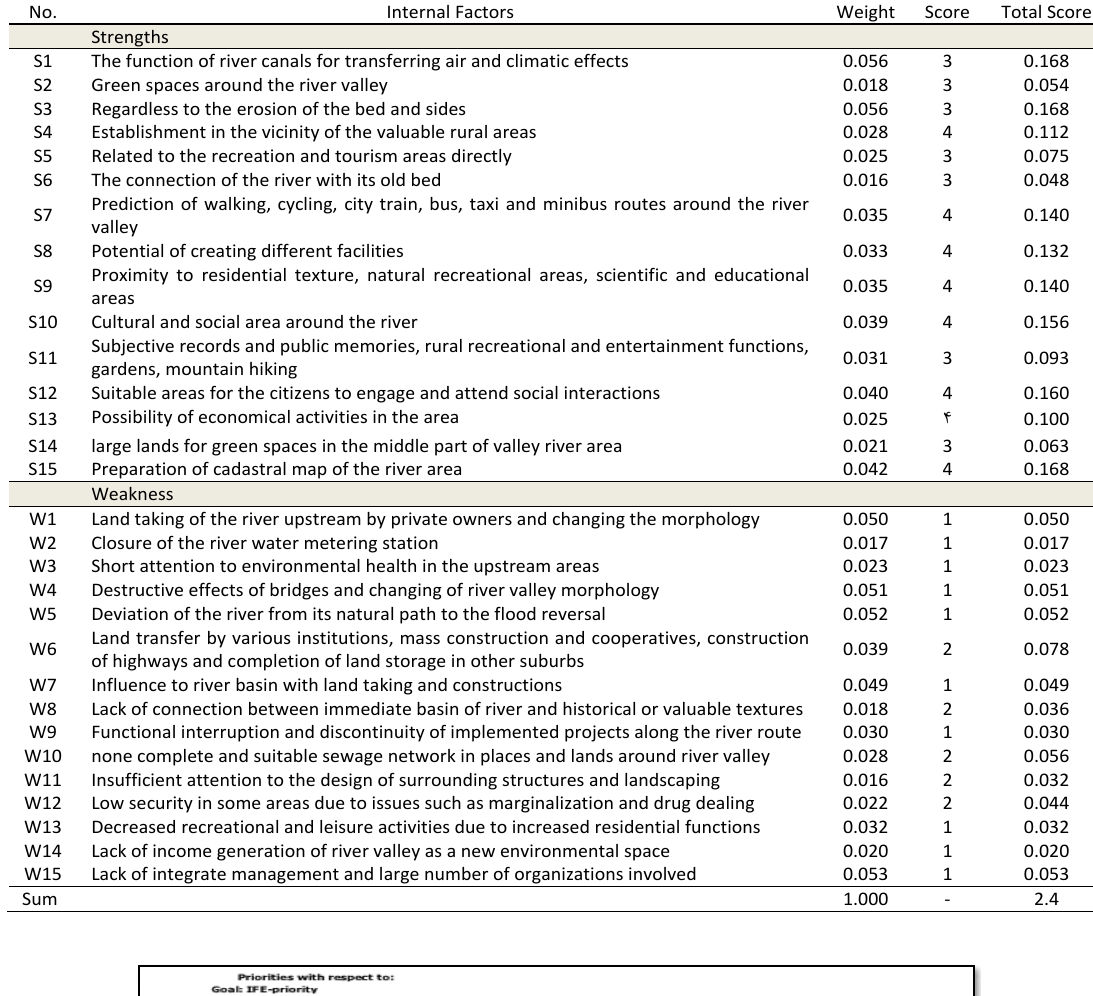
Table 2: IFE of Farahzad River Valley area